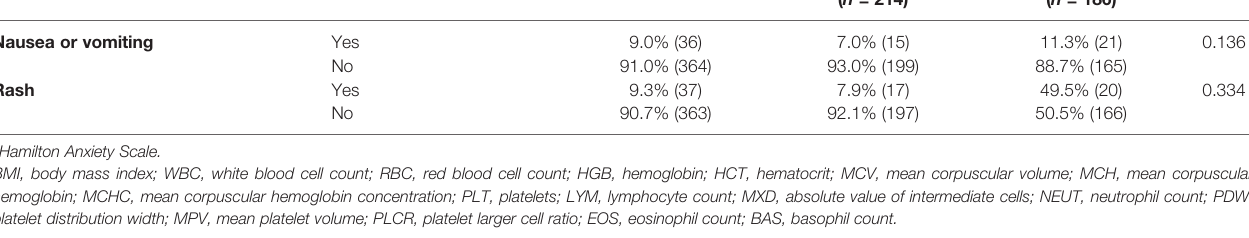
( Table 2 ). HIV VL at 3 months (aHR 1.7, 95% CI 1.4 – 2.1, per log increase), set point HIV VL (aHR 2.0, 95% CI 1.6 – 2.5),